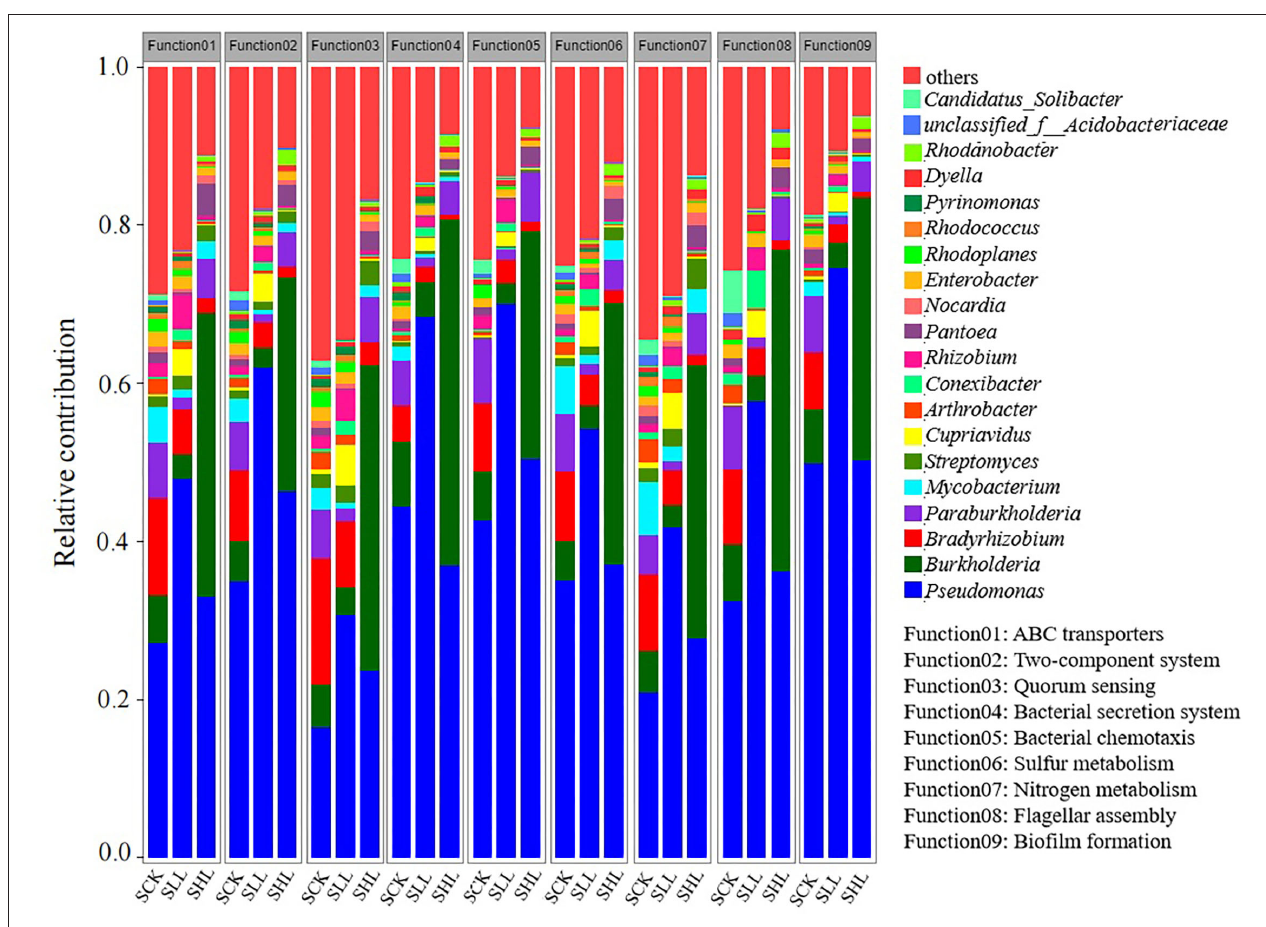
FIGURE 8 | The relative contribution of different taxa (the genus with more than 1% relative abundance) to identified rhizosphere functional attributes in different soil samples. SCK, soil without lime treatment; SLL, soil treated with low-level lime; SHL, treated with high-level